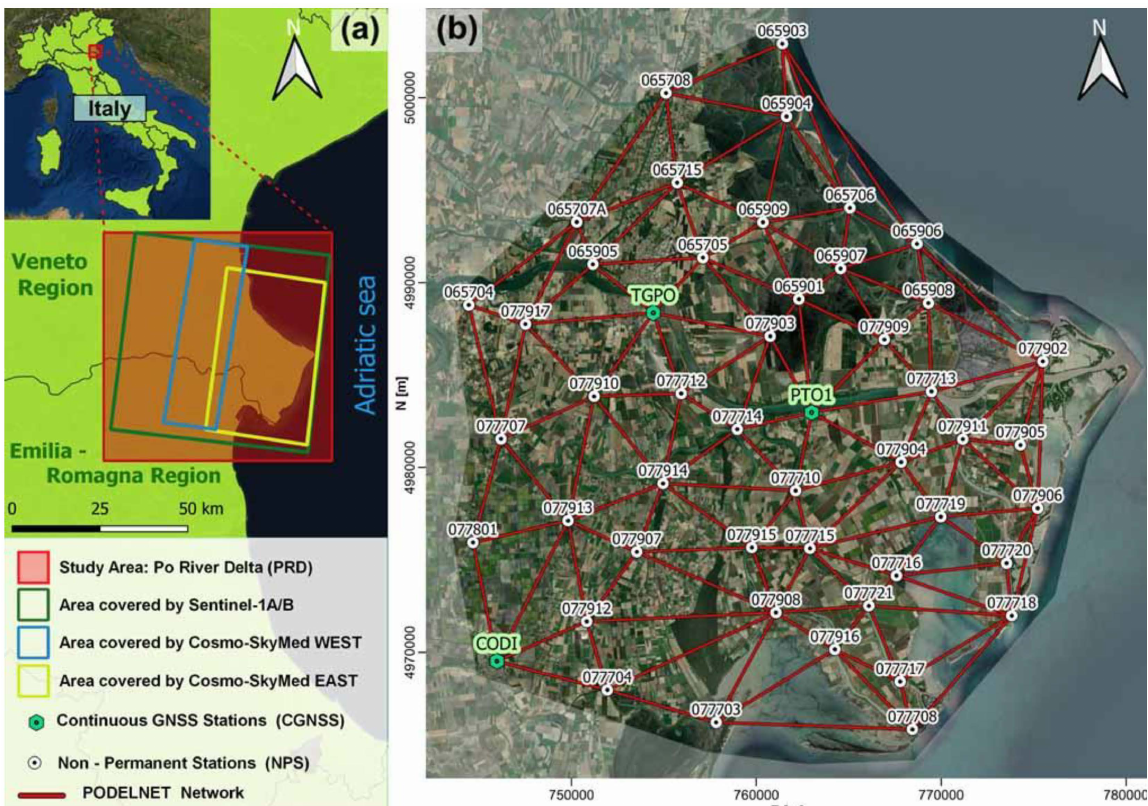
Figure 1. ( a ) Location of the study area with the coverage of Sentinel-1, CSK West, and CSK East stacks; ( b ) the Po River Delta (PRD) and PODELNET network with the indication of the CGNSS stations and the NPS points. The 130 measured baselines are also